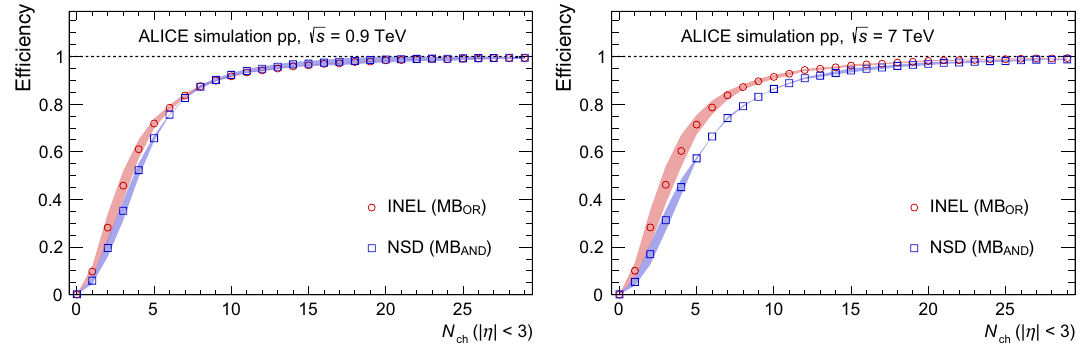
Fig. 2 Event selection efficiencies for 0.9 and 7 TeV for both INEL and NSD event samples as a function of the number of primary-charged particles for the | η | < 3 . 0 range Table 2 Systematic uncertainties (in percent) for the efficiency correction, for the INEL, NSD and INEL > 0 event classes. Numbers are given for multiplicity 0, 1, and